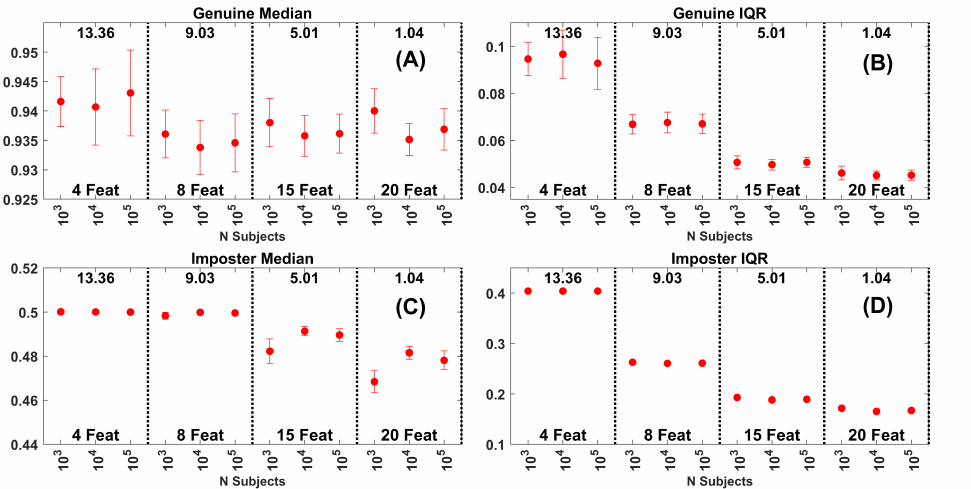
Figure 11. ( A ) Median of the genuine similarity score distributions for synthetic data. Data are for the Band 8 data set with 4, 8, 15 and 20 features. Each dot is based on 30 repetitions. The error bars are at ± 1 SD . The numbers at the top of each plot are the average EERs across the gallery sizes represented. ( B ) IQR of the genuine similarity score distributions for the same data in ( A ). ( C ) Median of the impostor similarity score distributions. ( D ) IQR of the impostor similarity score